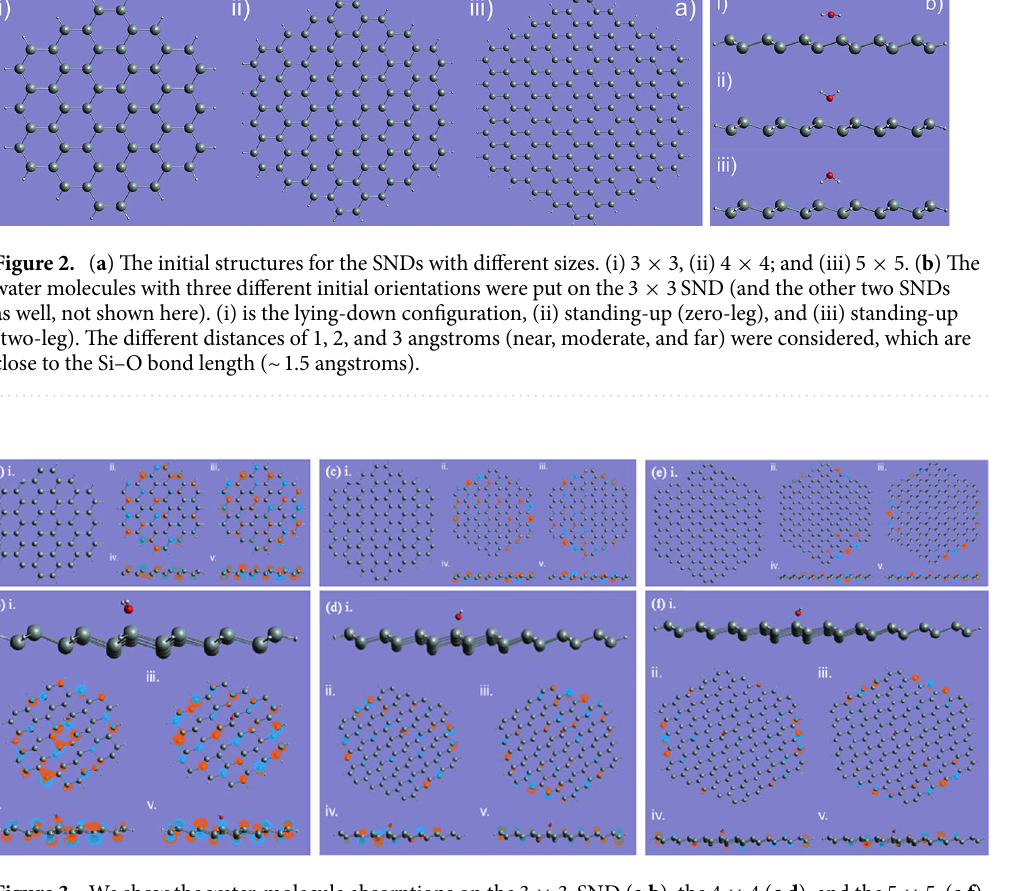
Figure 3. We show the water-molecule absorptions on the 3 × 3 SND ( a , b ), the 4 × 4 ( c , d ), and the 5 × 5 ( e , f ). The optimized structures without and with the water molecule are shown in (i) for each scenario, respectively. In each sub-figure, (ii) and (iii) ((iv) and (v)) are the top (side) views of HOMO and LUMO,